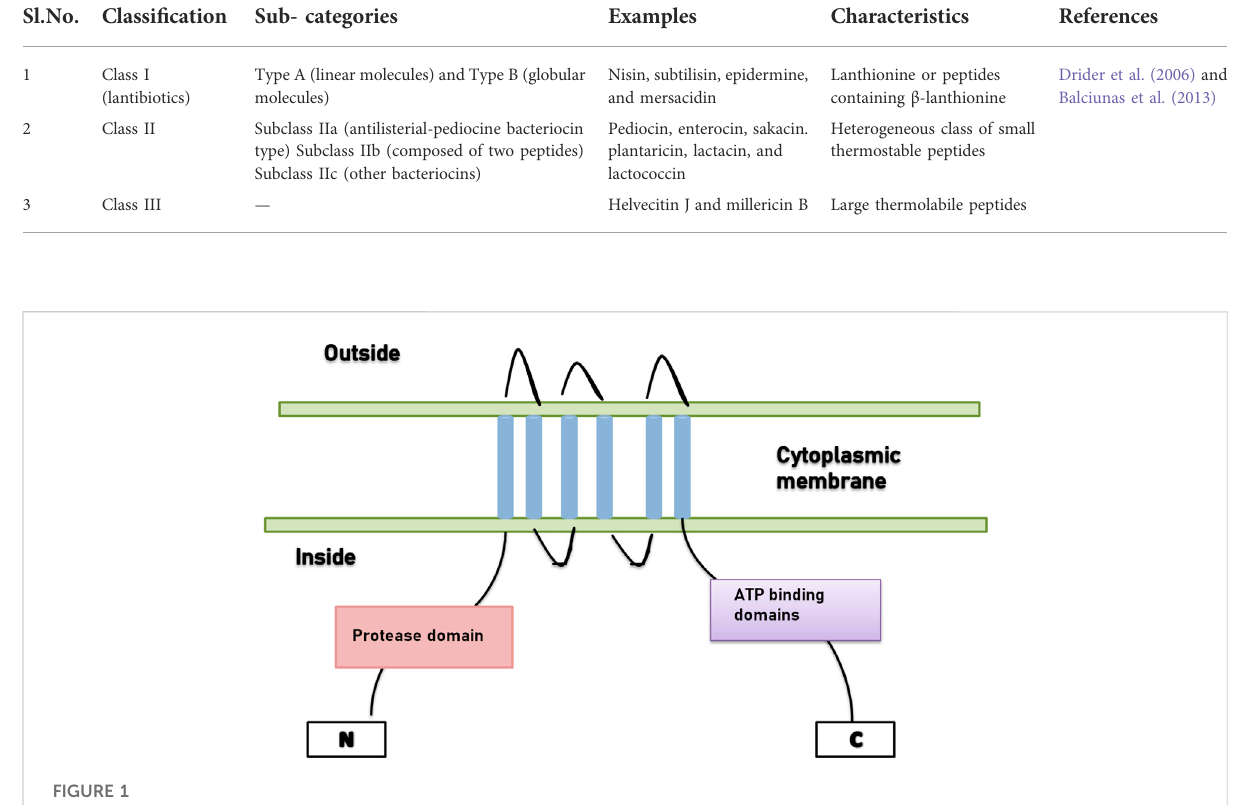
FIGURE 1 ABC-transporter with N-terminal